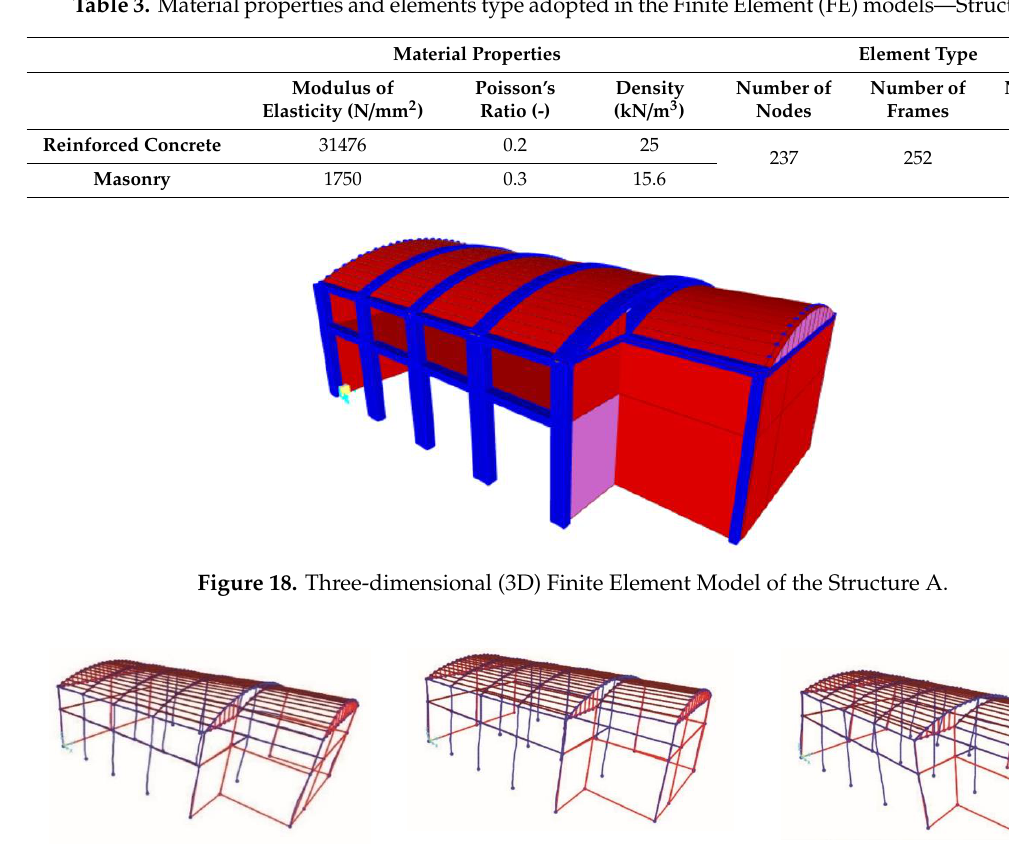
Table 3. Material properties and elements type adopted in the Finite Element (FE) models—Structure A.